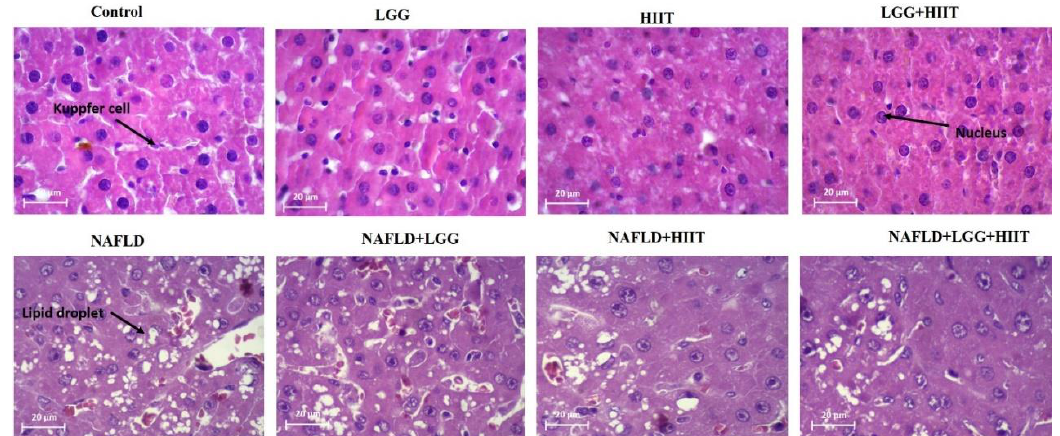
Figure 2: Effects of HIIT on hepatic steatosis. Representative images of hematoxylin and eosin (H&E, magnification 20 um). LGG: Probiotic L. rhamnosus GG, HIIT: High intensity interval training,